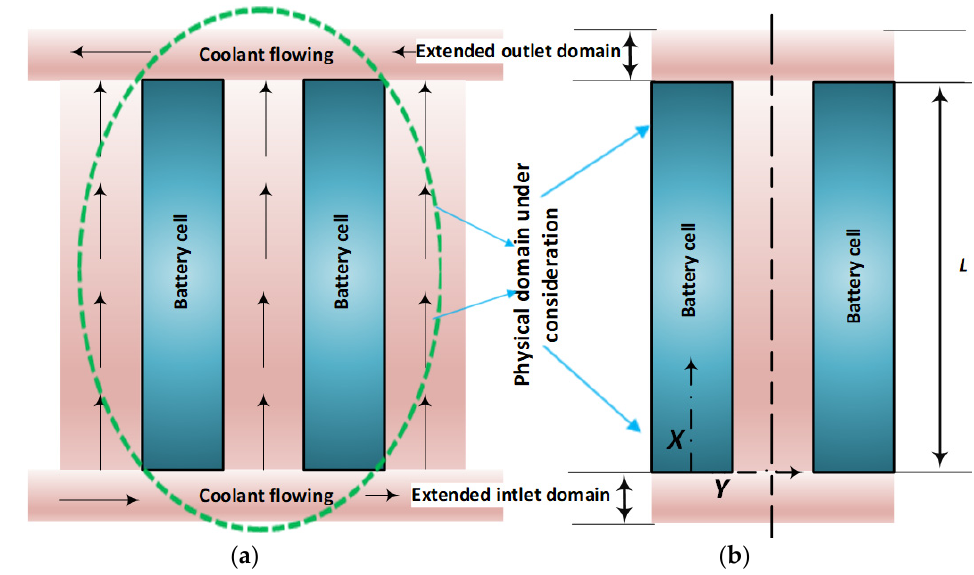
Figure 1. Proposed BTMS: ( a ) Battery cooling system; ( b ) Simplified model for numerical analysis.